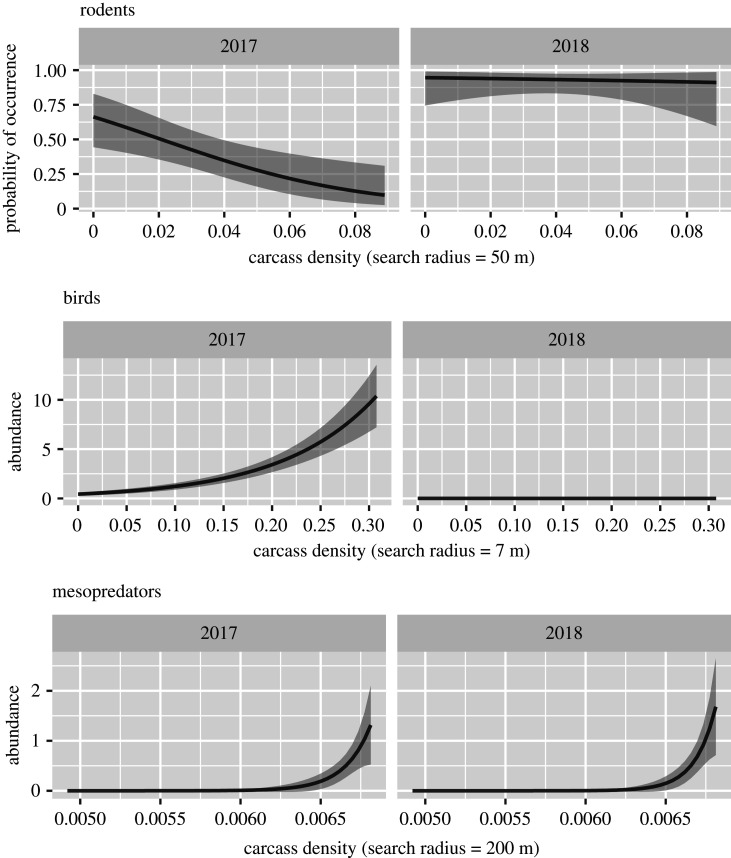
The analysis from Steyaert et al. [27] was adapted, i.e. only carcass density was used from a range of search radii as a covariate, and an interaction with year (2017 and 2018) was added to assess how each rodent presence, bird abundance and mammal abundance responses varied between years and with carcass density. Model selection (AICc) was used across each response and with the search radius of carcass density ranging (1, 2, 3, 4, 5, 6, 7, 8, 9, 10, 15, 20, 30, 40, 50, 100, 200 m). A residual autocovariate (RAC) was used in model structures for mesopredator and bird abundance responses, as those models depicted spatial autocorrelation (SAC; Moran's I test) in the residuals. Model selection was repeated and the most parsimonious models with RACs did not show SAC in the residuals (Moran's I test; p-value > 0.05). Rodent presence was significantly and negatively related with carcass density (r = 50 m; β = –32.6, s.e. = 11.5, p-value = 0.005) in 2017, but was independent of carcass density (β = 26.5, s.e. = 21.3, p-value = 0.212) and had a higher probability of occurrence in 2018 (ref year = 2017; β = 2.19, s.e. = 1.02, p-value = 0.033). Bird abundance was the opposite, with significantly higher abundance in higher carcass densities (r = 7 m; β = 10.3, s.e. = 0.904, p-value ≤ 0.001) and in 2017 (ref year = 2017; β = –3.22, s.e. = 1.45, p-value = 0.026) when compared with 2018 (also with no significant relationship with carcass density this year; β = –16.8, s.e. = 19.1, p-value = 0.379). For both years, mesopredator abundance was positively related to carcass density (r = 200 m; β = –42.03, s.e. = 11.96, p-value < 0.001) and did not significantly change across years (ref year = 2017, β = 1563, s.e. = 2652, p-value = 0.556). Model predictions across the observed ranges of carcass densities are shown above while holding the autocovariates at their mean values (for bird and mesopredator responses only).